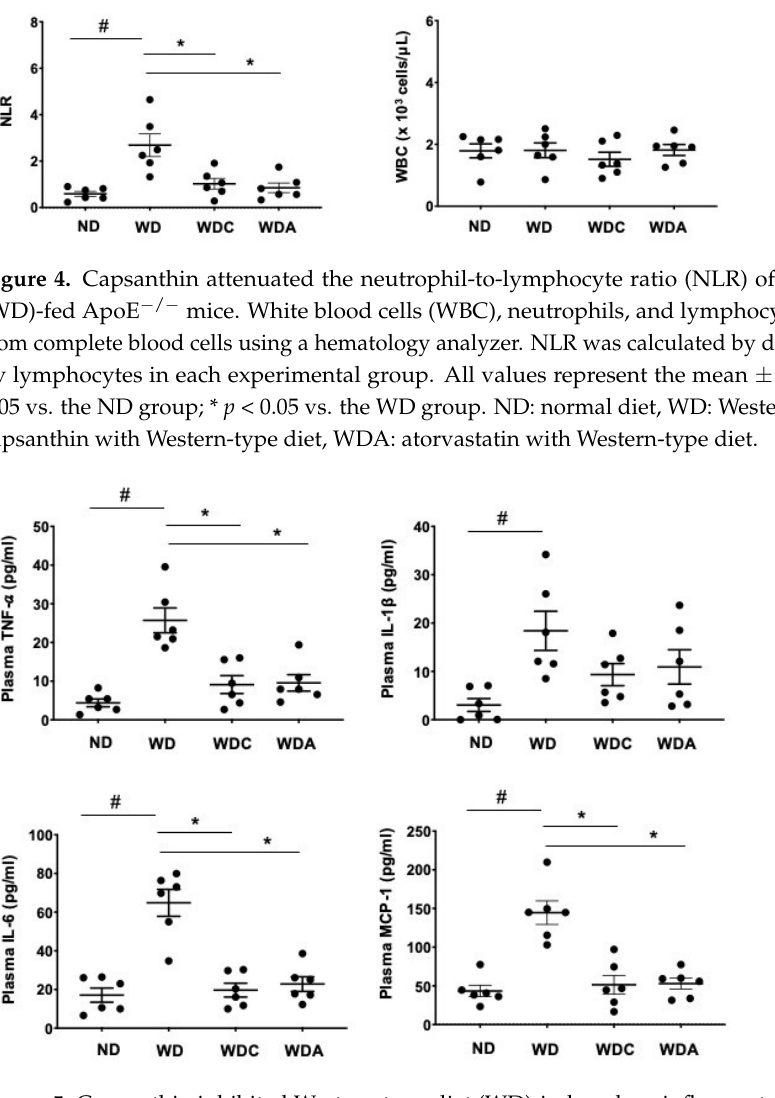
Figure 4. Capsanthin attenuated the neutrophil-to-lymphocyte ratio (NLR) of Western-type diet (WD)-fed ApoE −/− mice. White blood cells (WBC), neutrophils, and lymphocytes were analyzed from complete blood cells using a hematology analyzer. NLR was calculated by dividing neutrophils by lymphocytes in each experimental group. All values represent the mean ± SEM ( n =6). # p < 0.05 vs. the ND group; * p < 0.05 vs. the WD group. ND: normal diet, WD: Western-type diet, WDC: cap- santhin with Western-type diet, WDA: atorvastatin with Western-type diet.